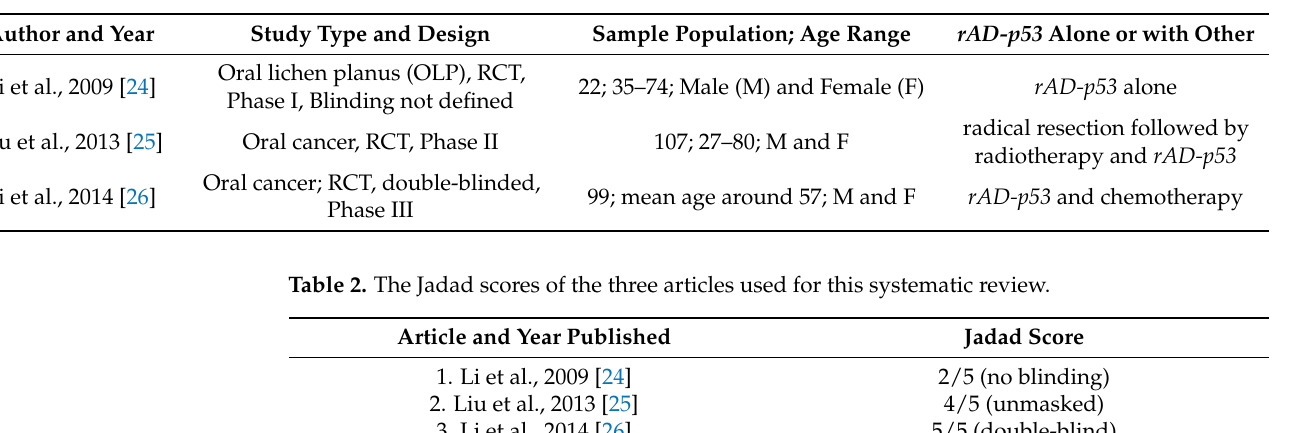
Table 2. The Jadad scores of the three articles used for this systematic review.